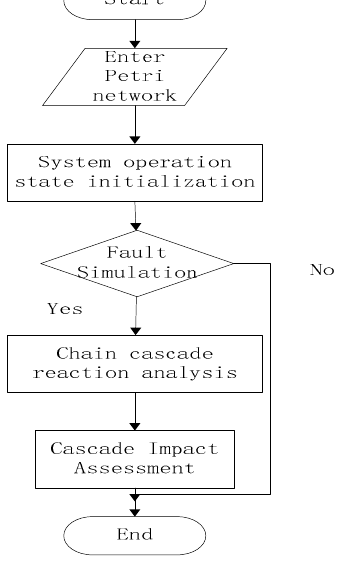
Figure 7. Algorithm flow chart.